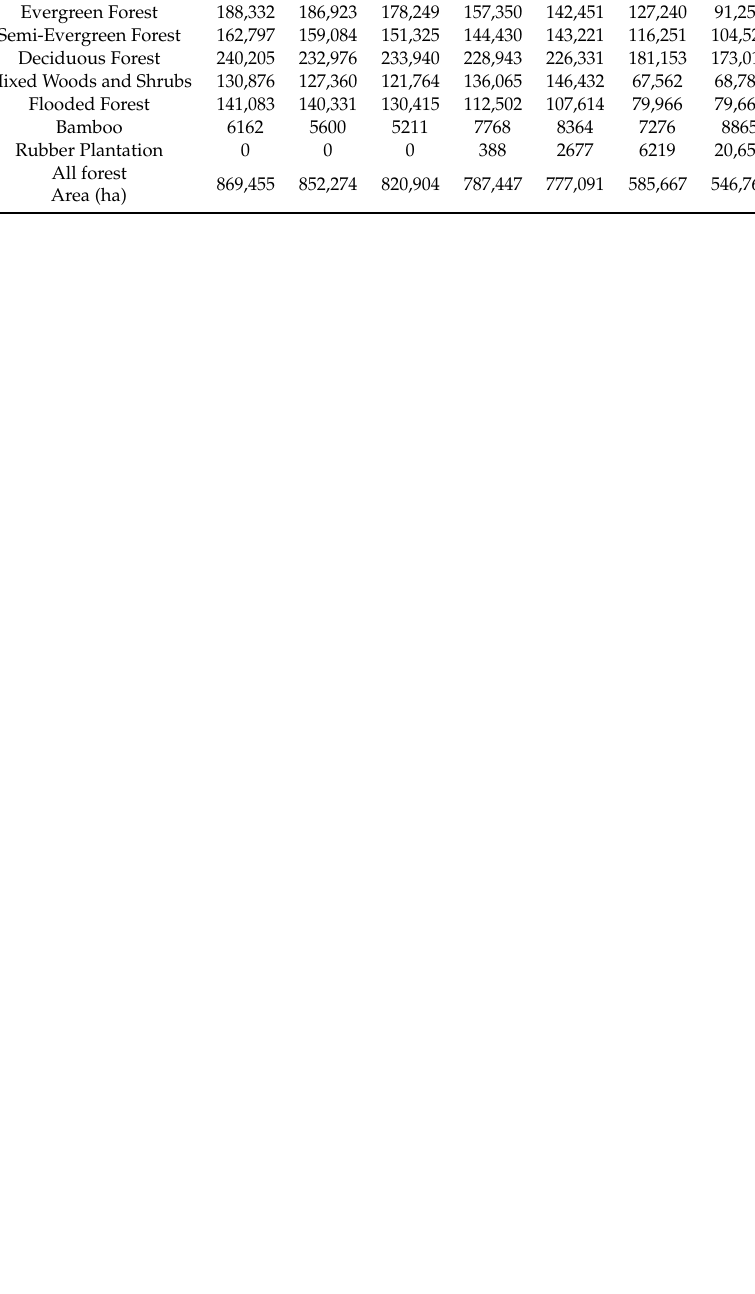
Forest Category